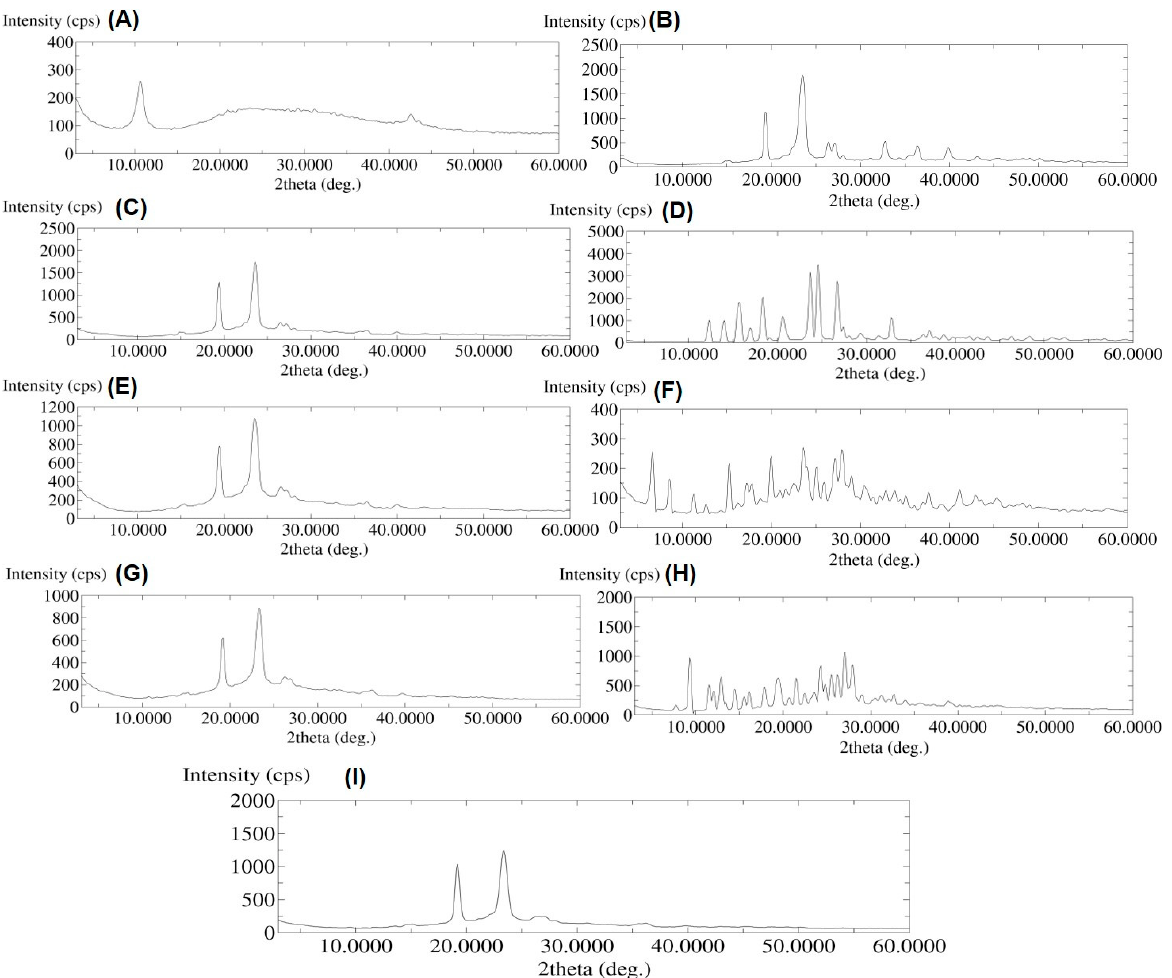
Figure 7. PXRD pattern of ( A ) NGO, ( B ) PEG 6000, ( C ) NGO-PEG, ( D ) AMP, ( E ) AMP loaded NGO-PEG, ( F ) DIC, ( G ) DIC-loaded NGO-PEG, ( H ) MTX, and ( I ) MTX-loaded NGO-PEG.